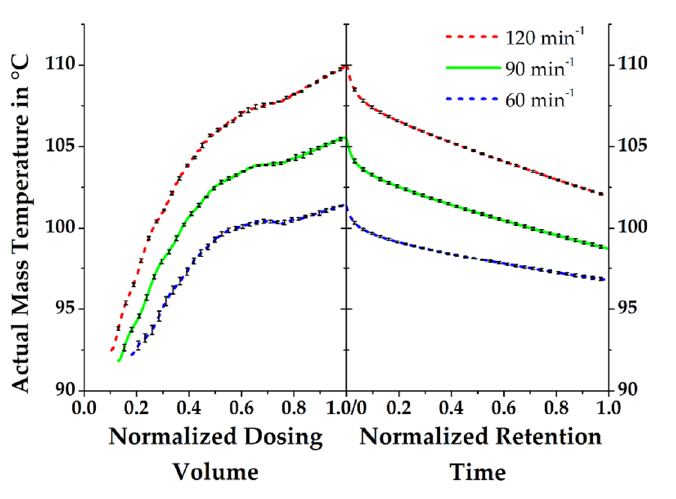
Figure 5. Actual mass temperatures obtained at screw rotational speeds of 60, 90, and 120 min − 1 . The rubber compound gains heat due to dissipation during dosing and emits heat during the retention time.